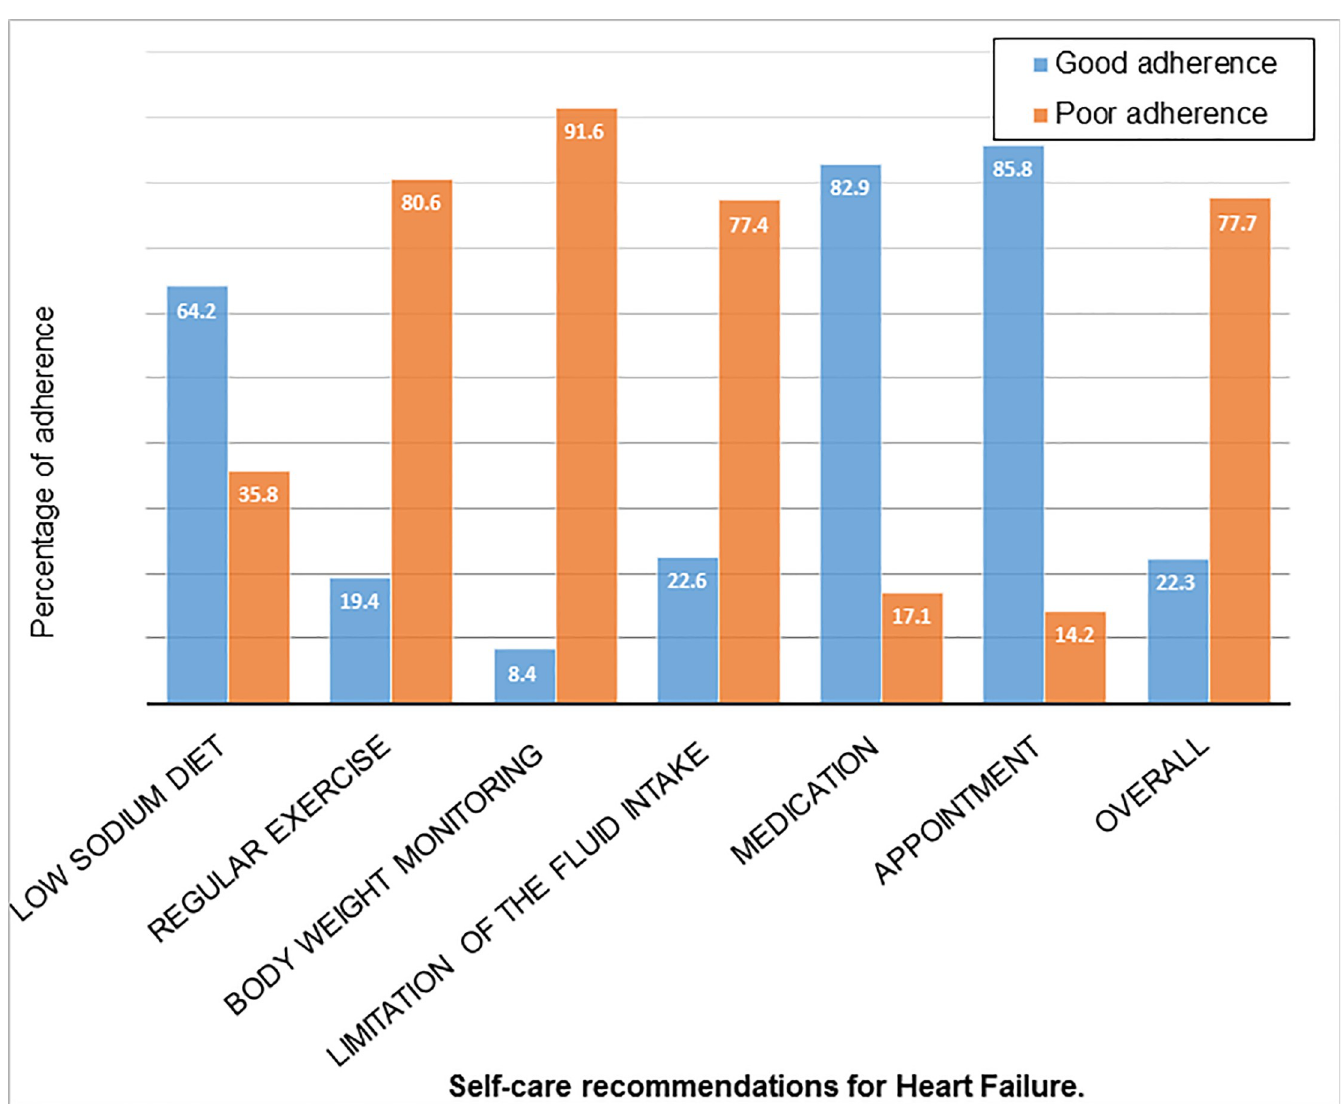
Fig 1. Adherence status of heart failure patients to self-care recommendations at Gondar University referral hospital, Northwest Ethiopia, May 2017 (n = 310).